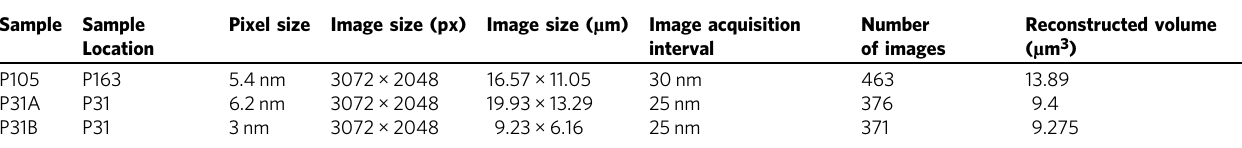
Table 2 FIB-SEM nanotomography parameters for volumetric reconstruction of data. Sample Sample